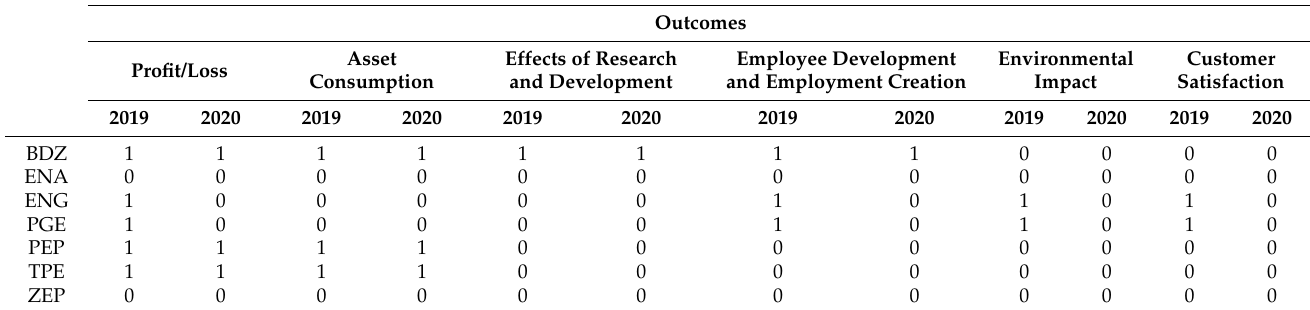
Table 8. Outcomes—the capital of the business models of enterprises in the energy sector for